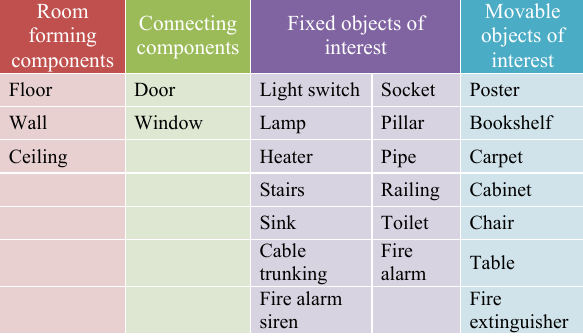
Table 1. Overview over the 25 categories of interiors we are